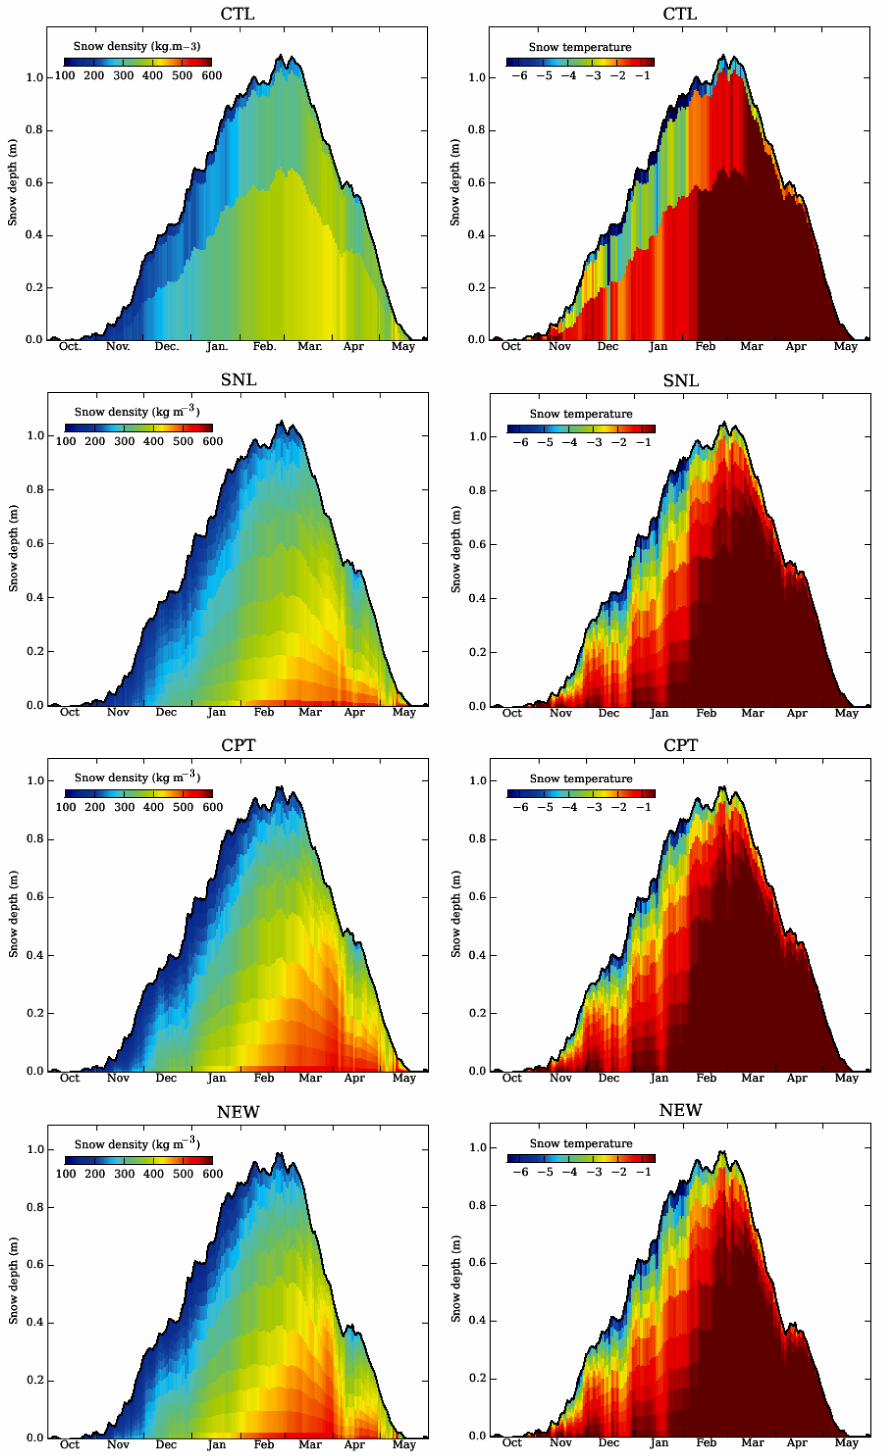
Figure 6. Daily mean annual cycles of snow density (kgm − 3 ) and snowpack internal temperature ( ◦ C) simulated by the four experiments over 18 years at the Col de Porte field